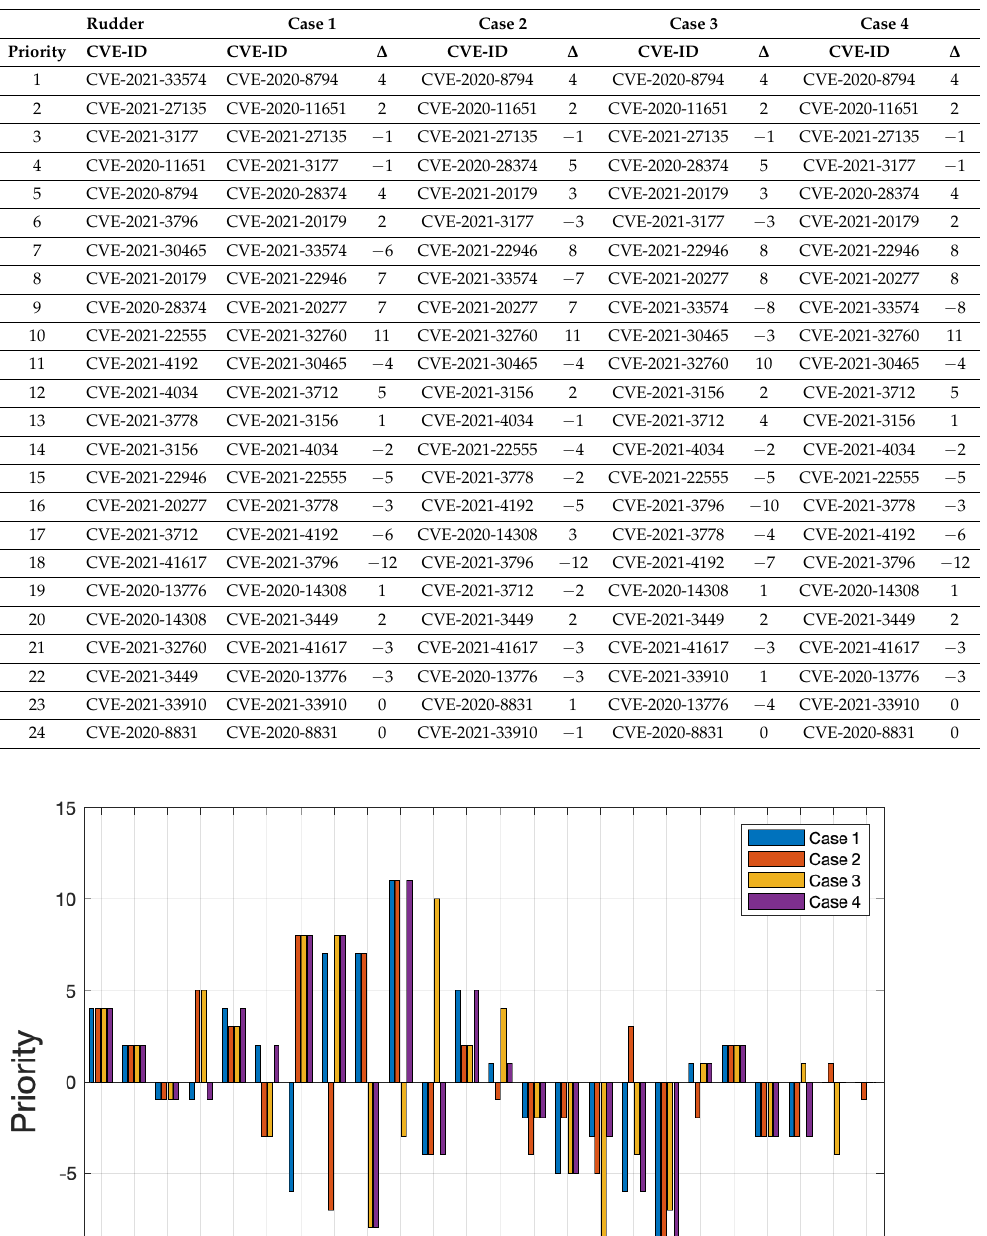
Table 8. Patch priority list in test environments by Rudder CVE-plugin and ACVRM.